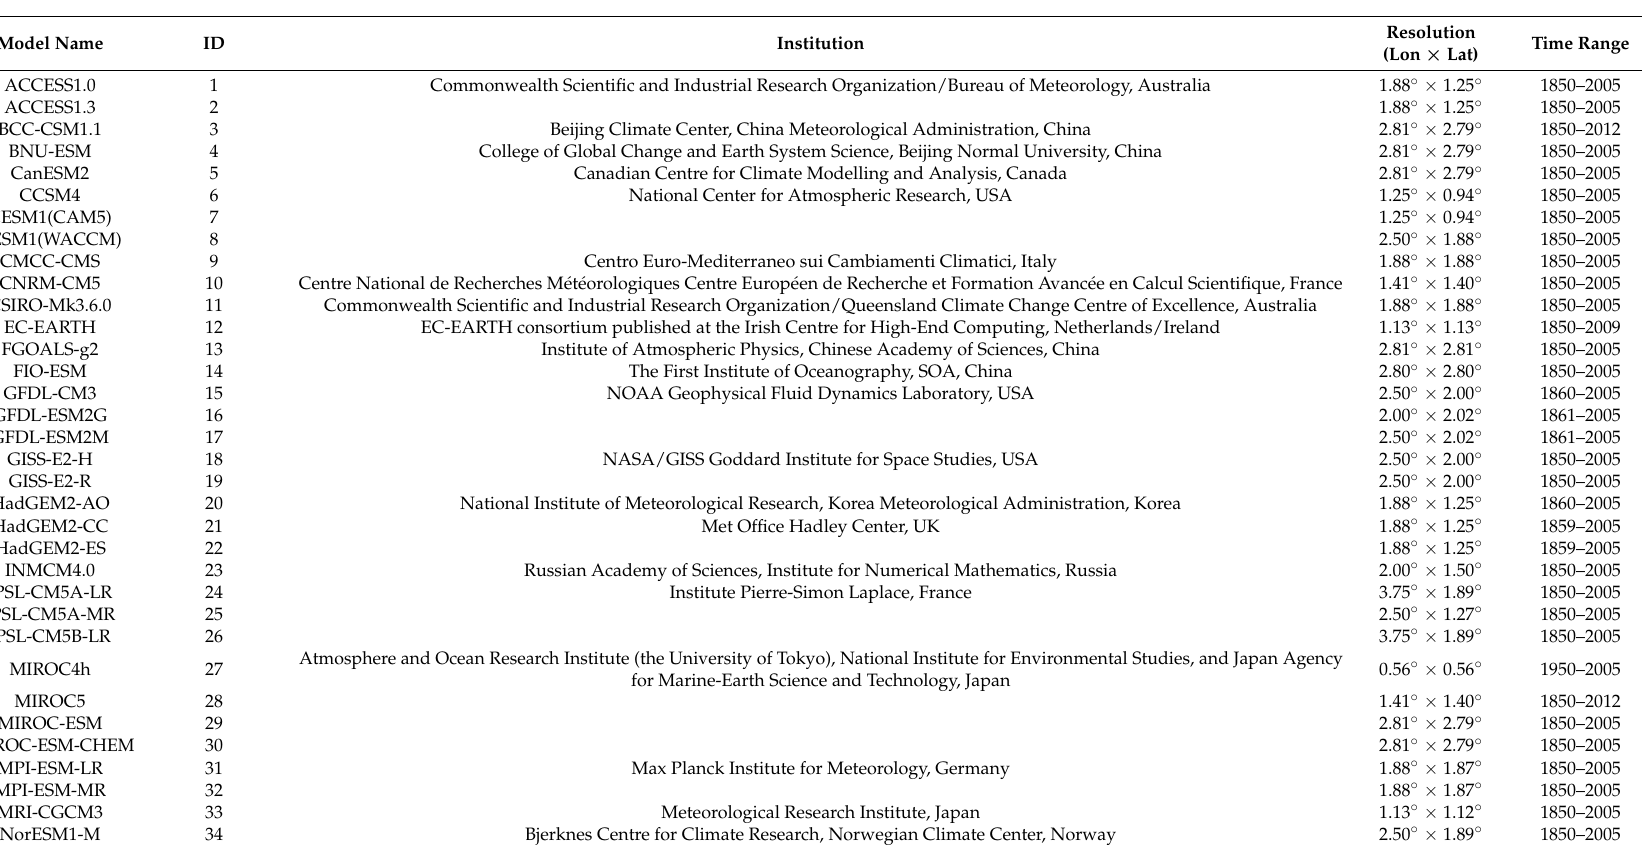
Table 1. Basic information of the Coupled Model Intercomparison Project 5 (CMIP5) models used in this